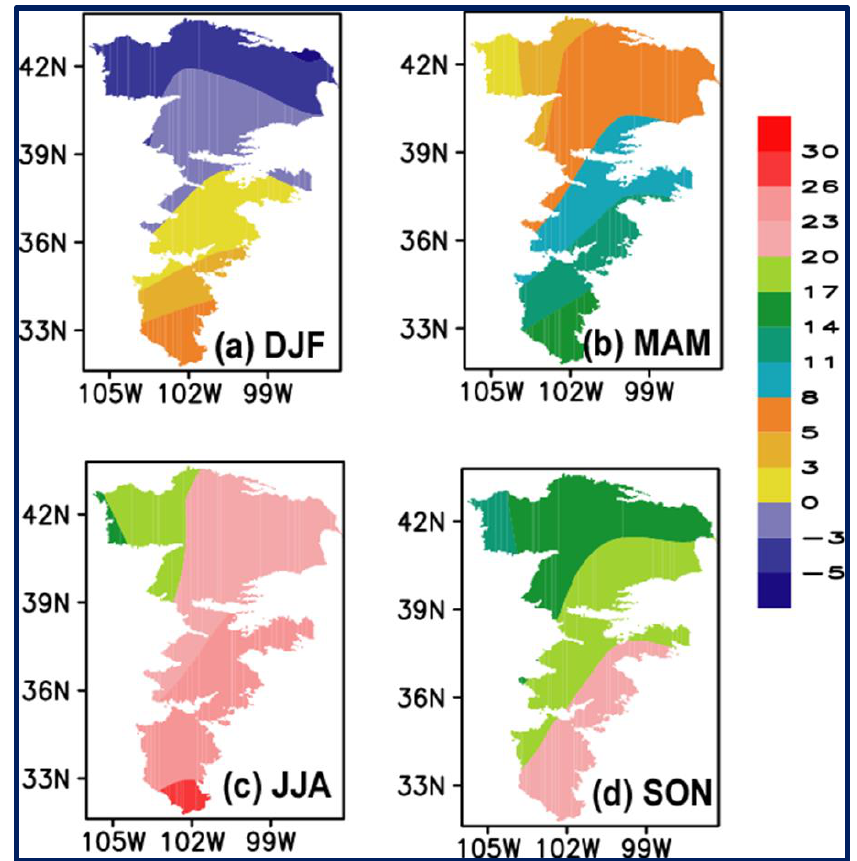
Figure 3. Observed seasonal mean temperature (°C) over the Ogallala Aquifer region during 1971 – 2005 ( a ) Winter (DJF — December – January – February), ( b ) Spring (MAM — March – April – May), ( c ) Summer (JJA — June – July – August) and ( d ) Fall (SON — September – October – November). The precipitation distribution depicts a seasonal east-west gradient. High seasonal precipitation values are observed in the northeast region of the aquifer, except in winter Precipitation was high in the central-eastern part of the aquifer in all seasons, whereas the north-south gradient had low precipitation values during summer. Thus, the eastern region of the aquifer has the maximum precipitation during most seasons, while the western part of the aquifer requires irrigation. This results in greater water extraction from the aquifer, aquifer depletion, and a disturbance of the aquifer water balance. The precipitation values ranged from 95–45 mm in summer. The zonal distribution of precipitation in the northern sector of the aquifer marks a westward increase in precipitation from winter until summer, followed by a decrease in fall. The southern region of the aquifer has characteristically high precipitation values during fall compared to that of other